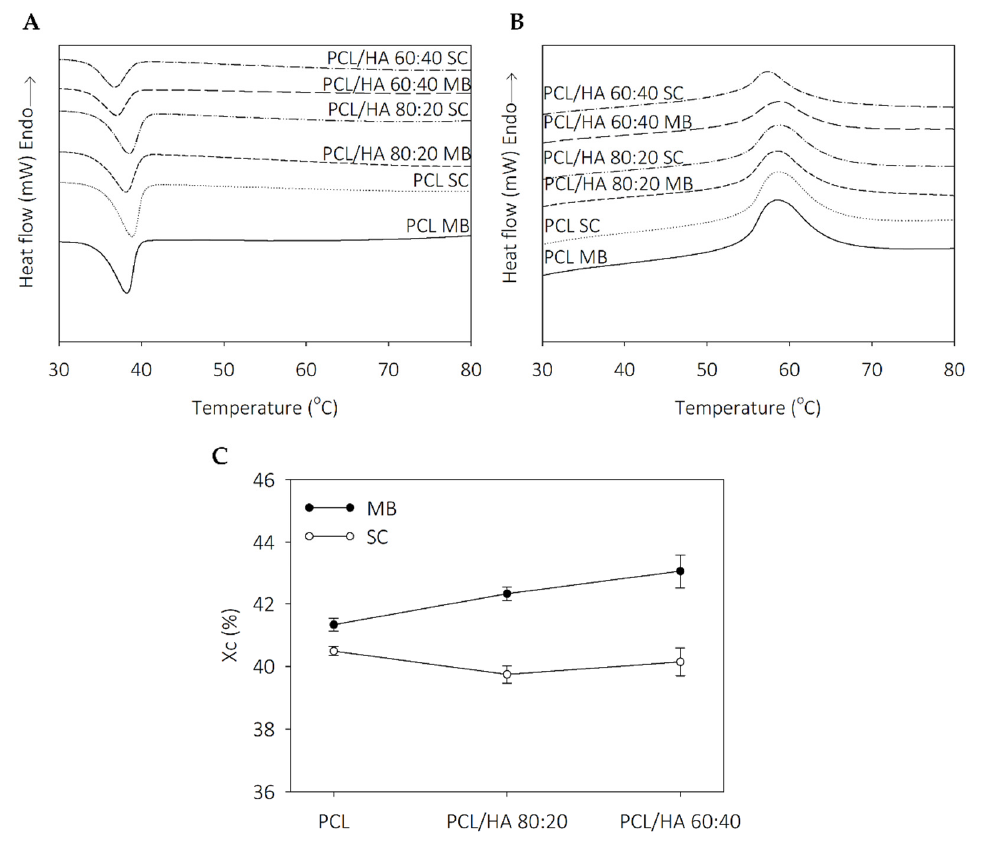
Figure 2. DSC thermograms: ( A ) cooling runs and ( B ) second heating runs; and ( C ) degree of crystallinity of PCL and PCL/HA composites. Table 1. Thermal properties of PCL and PCL/HA composites by DSC, TGA and DTG.